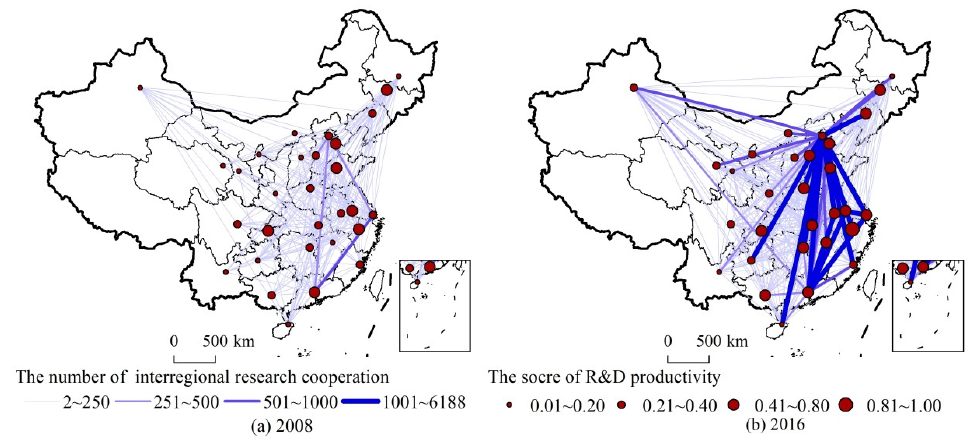
Figure 4. Spatial patterns of interregional collaboration and R&D productivity in 2008 and 2016 in China.